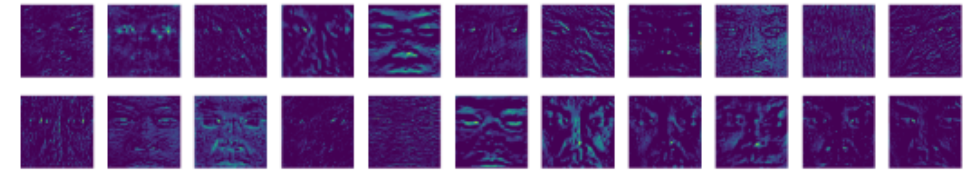
Figure 6. Attention ResNet Emotion (Stage-3) hidden layer visualization of residual